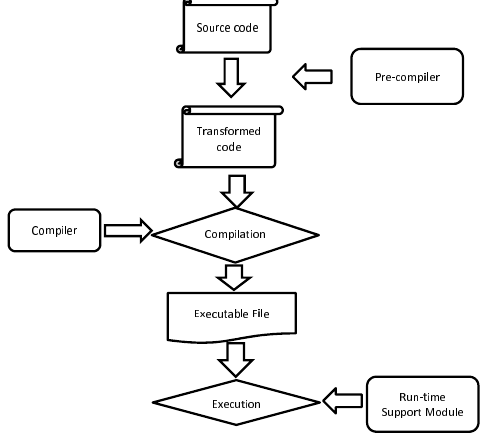
Fig. 2. Execution Process of the GPU Checkpoint/Restart